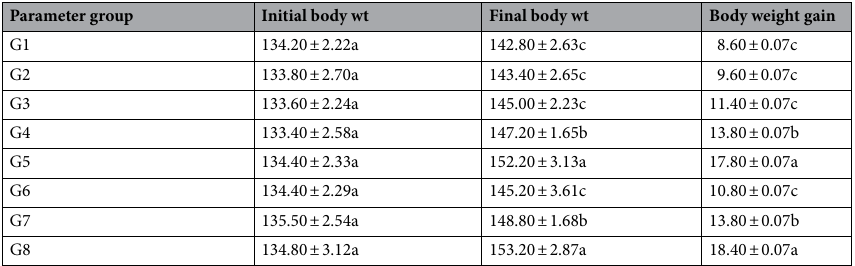
Table 1. The changes in the body weight and body weight gain in the normal control and different treated rat groups. G1 = control group, G2 = Paracetamol, G3 = Silymarin + Paracetamol, G4 = Chlorella vulgaris + Paracetamol, G5 = Chlorella vulgaris + Thiamine + Paracetamol, G6 = Silymarin, G7 = Chlorella vulgaris and G8 = Chlorella vulgaris + thiamine. Data are presented as means ± SEM (n = 6). Values having different superscripts within same column are significantly different ( p <